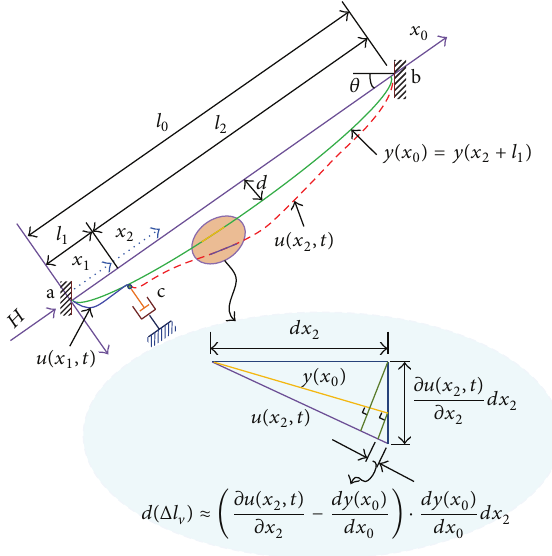
Figure 1: Schematic diagram of calculation of additional dynamic